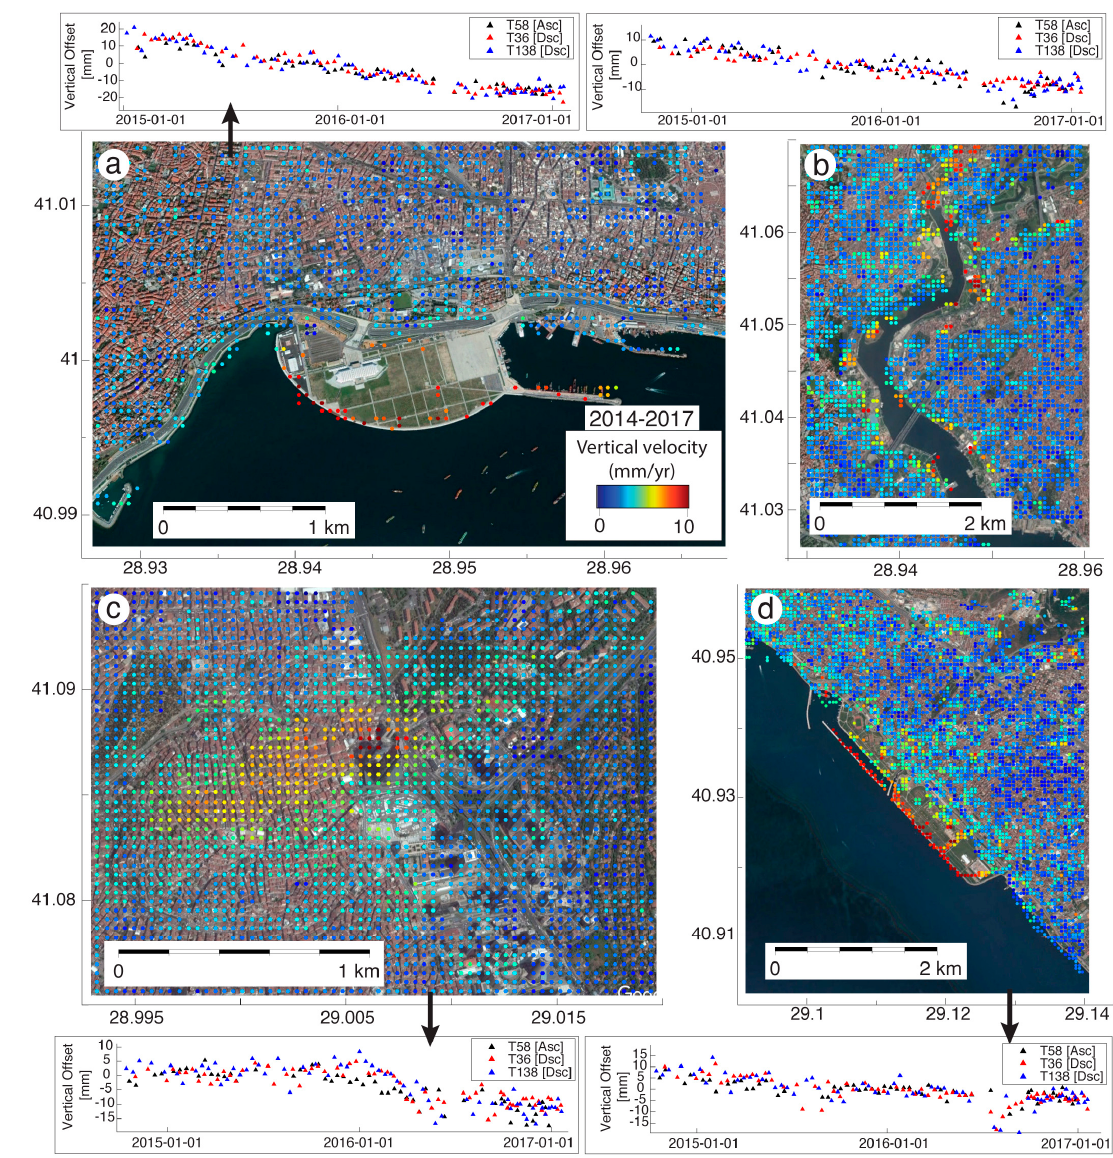
Figure 10. Vertical velocities obtained by the decomposition of mean velocity fields of Sentinel 1 data (T58 ascending track and T138 descending track) superimposed on a Google Earth image of Istanbul, and the relevant time series of the vertical displacement. Black, red, and blue triangles represent the ascending T58, descending T36, and descending T138 tracks, respectively. ( a ) Yenikapi coastal and land reclamation area (circle 4 in Figure 4a). The color scale represents the vertical displacement of the surface; ( b ) Golden Horn area (circle 3 in Figure 4a); ( c ) Highly urbanised area of Istanbul, with subsiding persistent scatterer points clustered around the highest skyscraper of Istanbul (circle 5 in Figure 4a); ( d ) Maltepe reclamation zone (circle 6 in Figure 4a).